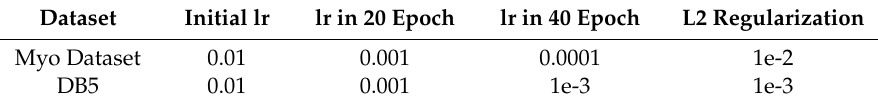
Table 2. Training policy parameter setting (lr represents the learning rate).